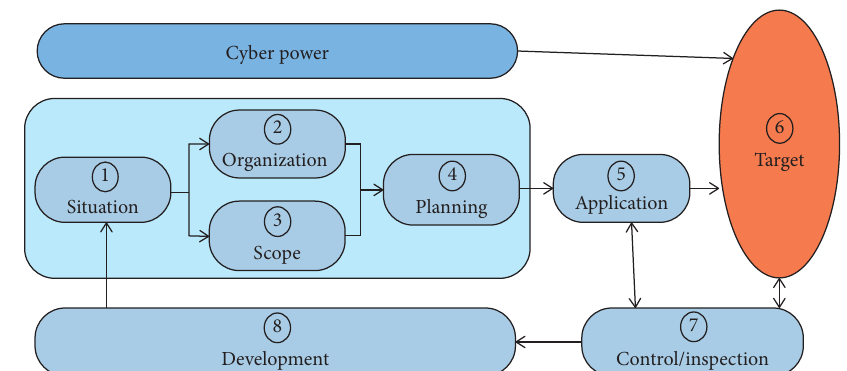
Figure 9: Proposal for creating a NCSS and implementation